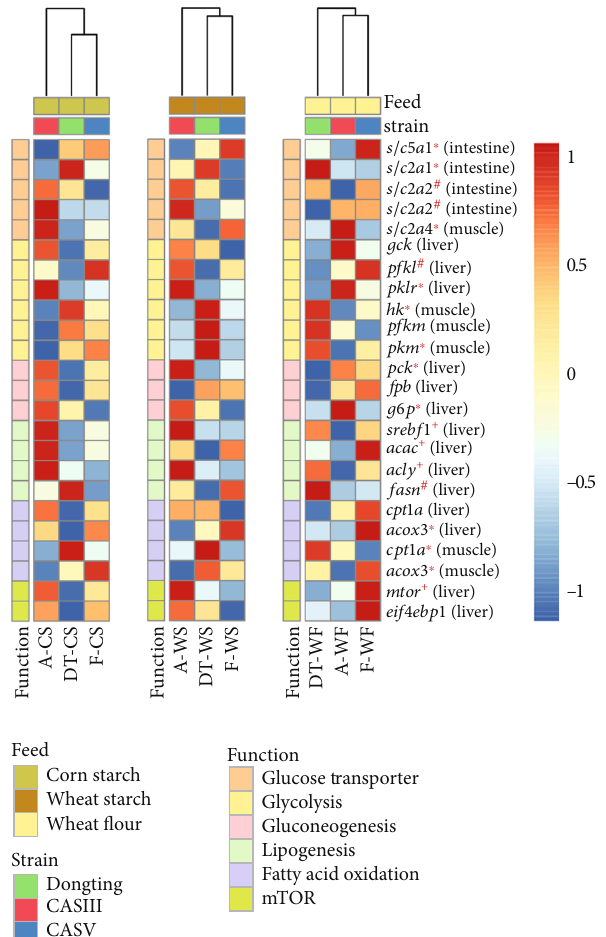
Figure 5: Heatmap illustrating the main patterns of gene expression involved in glucose and lipid metabolism within three strains fed di ff erent carbohydrate sources. Similarities between the groups, as shown by hierarchical clustering, can be seen above the heatmap with bootstraps. The intensity of the colour indicates the expression level: red, upregulated expression; blue, downregulated expression. Superscripts are labelled if there are signi fi cant di ff erences in gene expression according to the statistical analysis: ∗ indicates a signi fi cant di ff erence in gene expression between strains; + indicates a signi fi cant di ff erence in gene expression between carbohydrate sources; and # indicates a signi fi cant interaction of gene expression between strains and carbohydrate